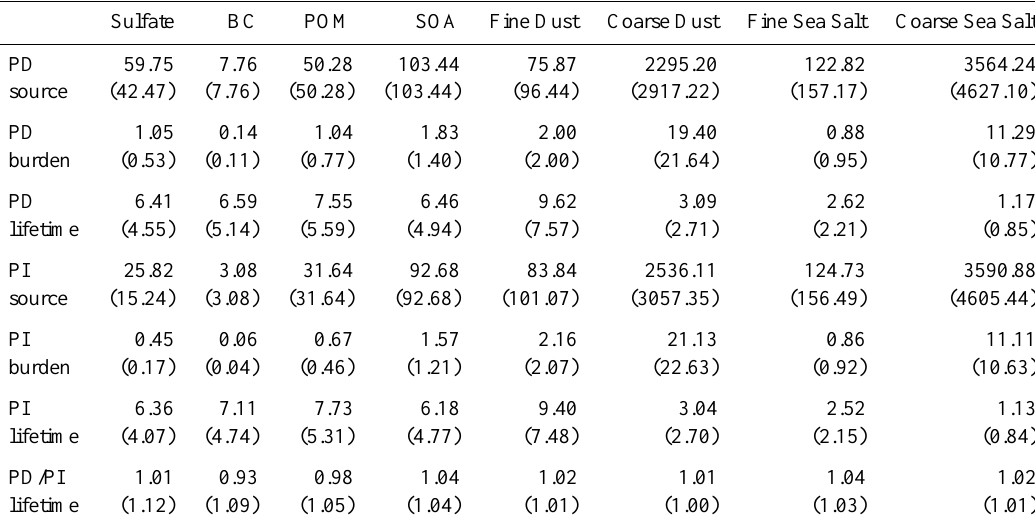
Table 2. Global annual budgets of sulfate, BC, POM, SOA, dust and sea salt in the PD and PI simulations of the MMF and CAM5. CAM5 results are in parenthesis. Dust and sea salt budgets are separated into fine mode (Aitken + accumulation) and coarse mode components. Units are days for lifetime, Tg for burdens and Tgyr − 1 for sources, except for sulfate where units are TgS and TgSyr − 1 for burdens and sources.